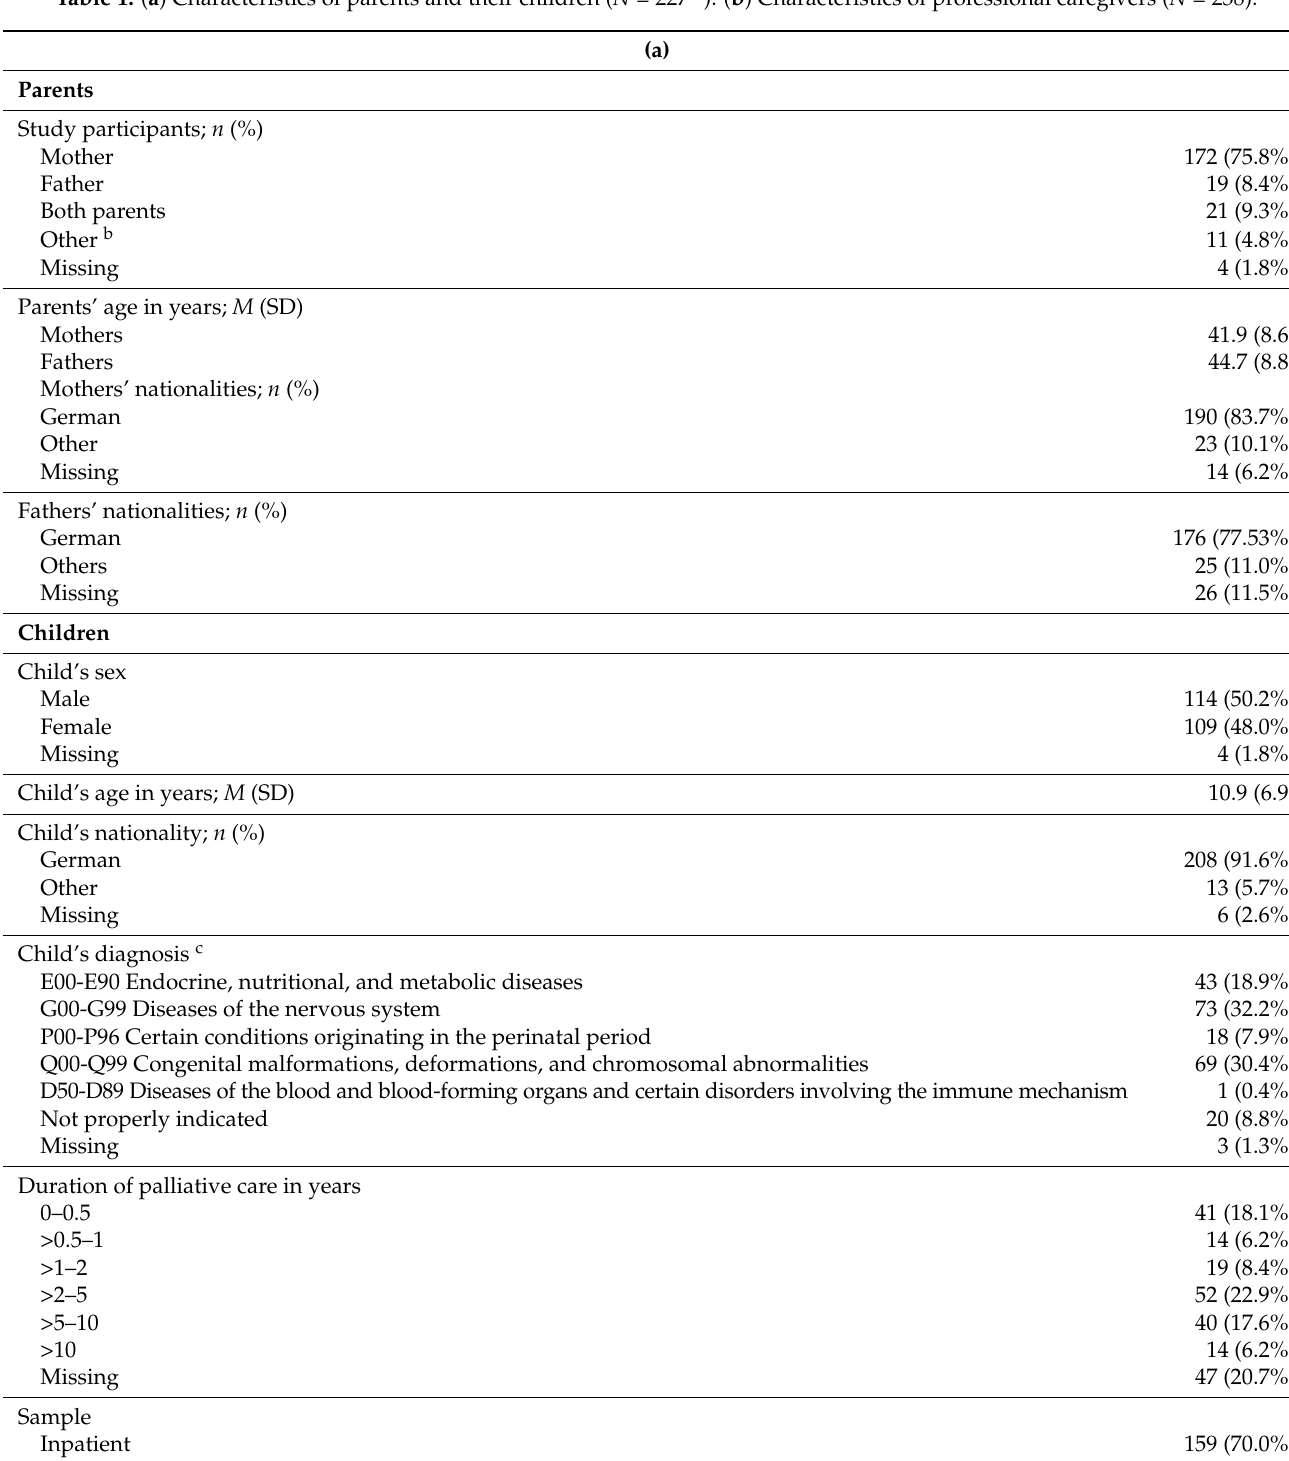
Table 1. ( a ) Characteristics of parents and their children ( N = 227 a ). ( b ) Characteristics of professional caregivers ( N =